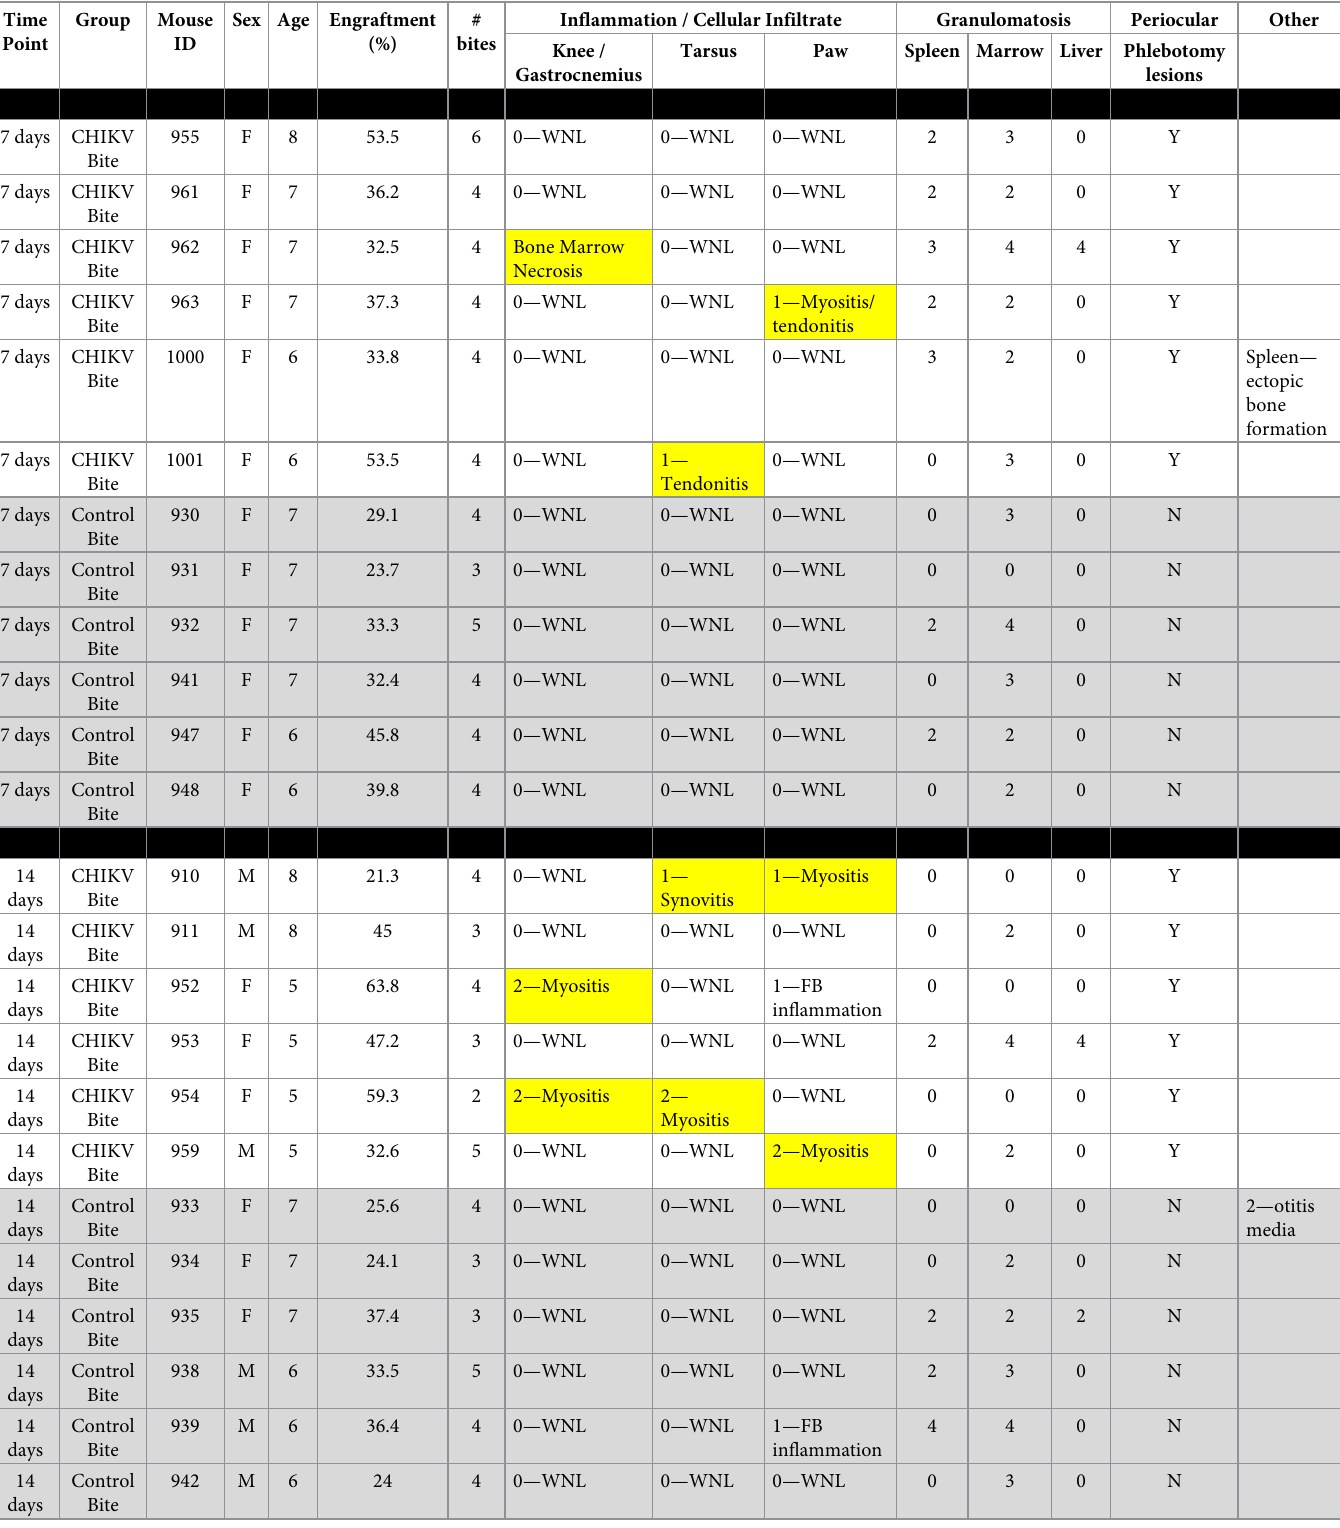
Table 2. Summary of histological scorings of Hu-NSG mouse joints and tissues in relation to animal and group information. Time Group Mouse Sex Age Engraftment Point ID